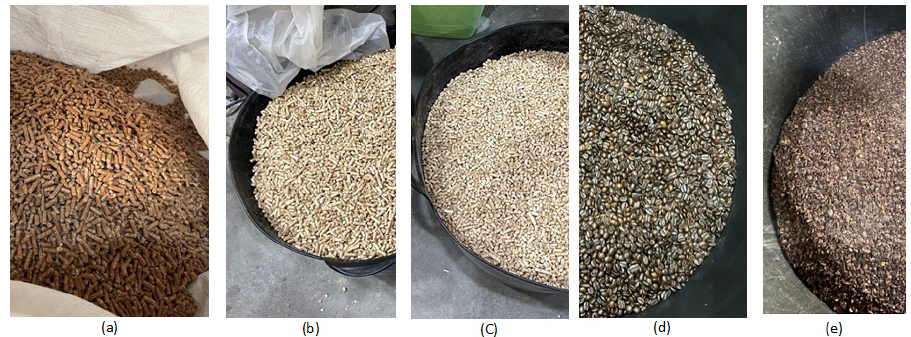
Figure 1. ( a ) Fresh wood pellets, ( b ) Aged wood pellets, ( c ) Degraded aged wood pellets, ( d ) Roasted coffee beans, and ( e ) Degraded coffee